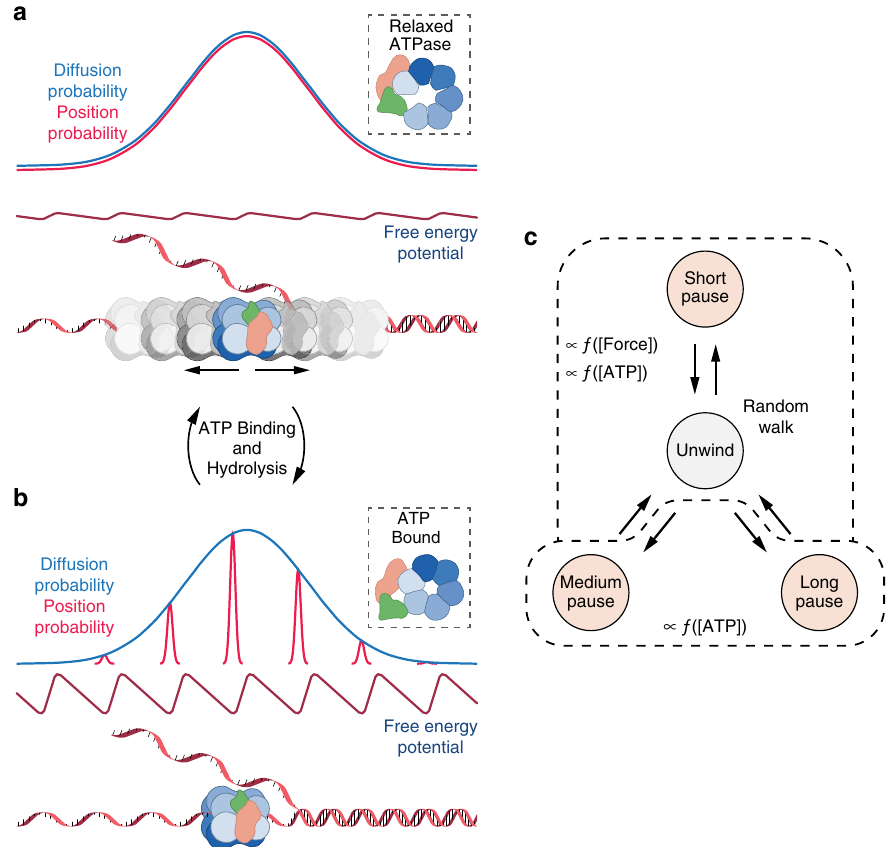
Fig. 5 Proposed Brownian ratchet mechanism and most likely kinetic scheme. a In the weakly bound state, open conformer where the Mcm2,5 gate is open (dashed box). CMG can undergo unbiased diffusion (random walk) along the DNA due to a weak free energy potential. b Upon ATP binding/hydrolysis CMG undergoes an allosteric structural change that alters the af fi nity for DNA, increasing the free energy potential of interaction with the DNA. In this state, CMG remains at the bottom of the potential well, fi xed in position. The asymmetry in the potential means that upon cycling between these two states through ATP hydrolysis CMG is more likely to be in the ( n + 1)th potential well representing the next base along, giving rise to a bias towards the unwinding direction. c The proposed kinetic scheme for DNA unwinding by CMG. The enzyme is in an active state, unwinding via a Brownian ratchet mechanism but may enter one of three pauses. The kinetics governing theses process are dependent on force applied to DNA and the ATP